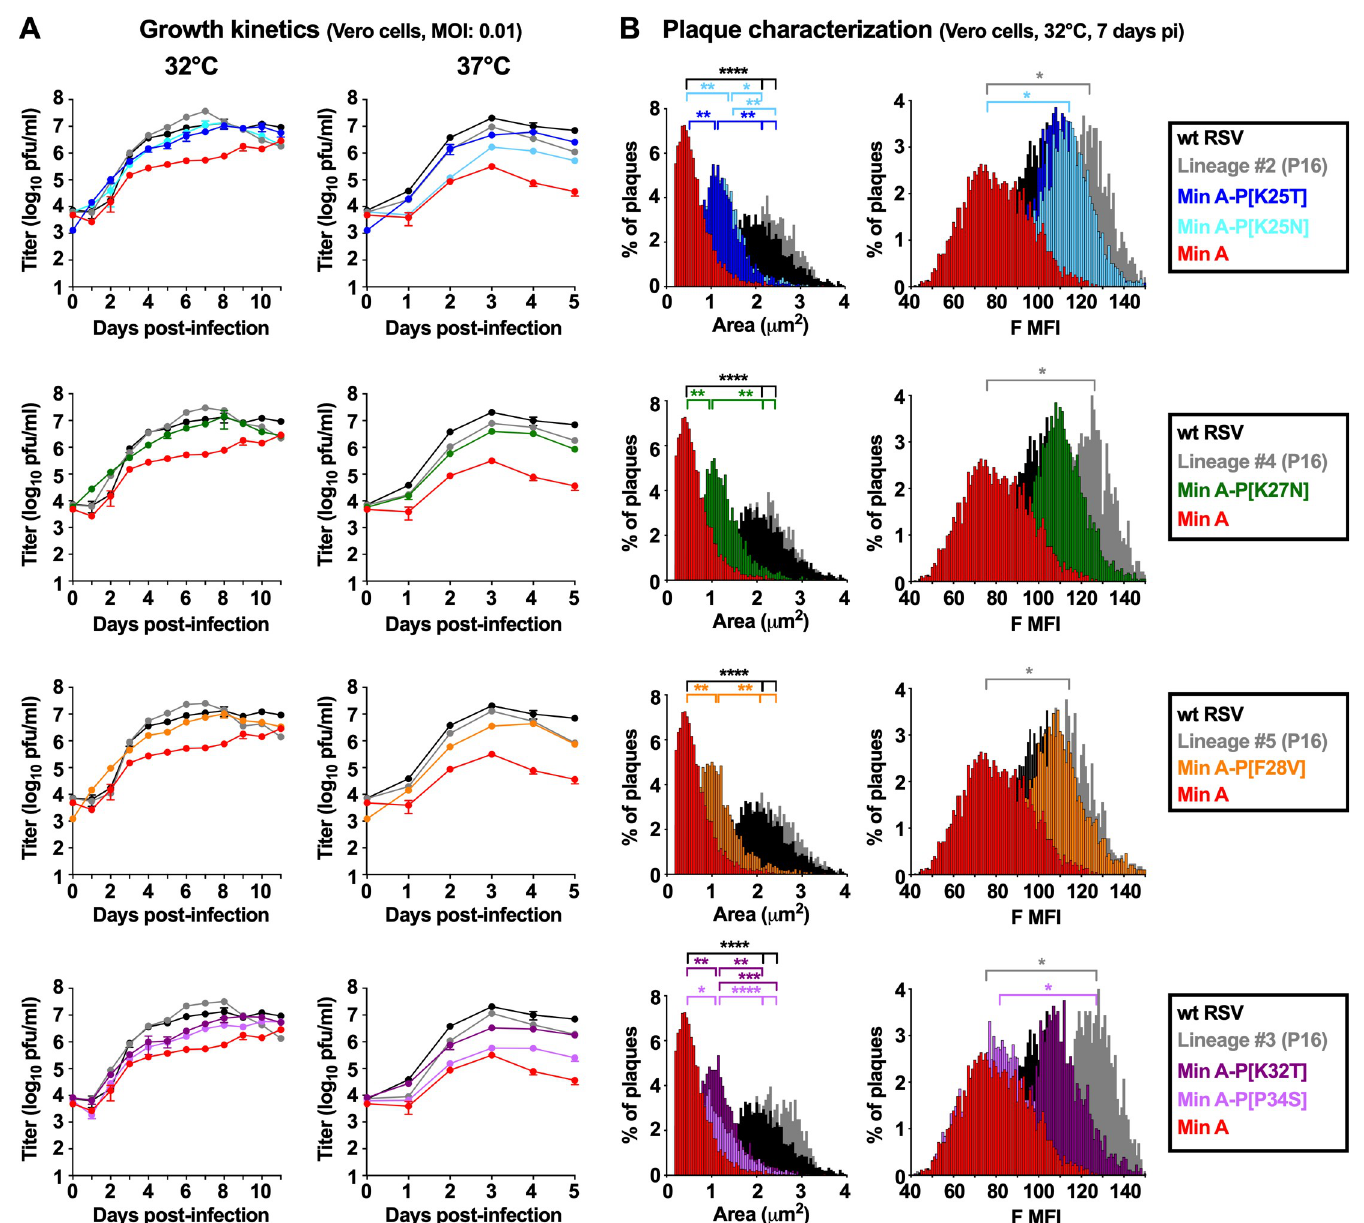
Fig 2. Effects of individual prominent P mutations on Min A replication, plaque size, and expression of F protein in vitro . (A) Multi-cycle replication kinetics: Vero cells in six-well plates were infected at an of MOI of 0.01 PFU/cell with wt RSV; Min A; P16 supernatant from Lineages #2, 3, 4, and 5 of the in vitro stress test; or Min A containing the individual indicated P mutations, and incubated at 32˚C (left column) or 37˚C (right column). For each virus, duplicate wells were harvested daily by scraping cells into the media followed by vortexing for 30 sec to release cell-associated virus. Clarified supernatants were snap-frozen until titrated by immunoplaque assay at the permissive temperature of 32˚C. Titers for Min A, Min A-derived mutants, and wt RSV correspond to the mean of two replicate titrations each of two replicate wells at each timepoint. Due to limited sample size, titers of the P16 viruses correspond to the mean of two replicate titrations of one well at each time point. Day 0 titers correspond to the back titration of the inocula. Note that all viruses were evaluated side-by-side in a single experiment but for clarity are shown in four separate graphs for each temperature, with the specific viruses evaluated in each graph identified in the black boxes at the far right-hand side of Part B, with wt RSV (black) and Min A (red) being repeated in each graph. (B) Plaque characterization : Vero cells in six-well plates were incubated with 250 PFU/well of the indicated virus at 32˚C. At day seven pi, plates were fixed with 80% methanol and plaques were stained with a cocktail of three anti-RSV F mAbs and a PE-labeled secondary antibodies as described in Materials and Methods. The plaque area (in μ m 2 ) and the level of RSV F expression (expressed as median fluorescence intensity, MFI) were evaluated on an average of 2140 ( ± 1167) plaques per virus. Distributions of the virus plaque area and F MFI were compared for statistical significance using the ANOVA test ( � = p � 0.05, �� = p � 0.01, ��� = p � 0.001, ���� = p � 0.0001).